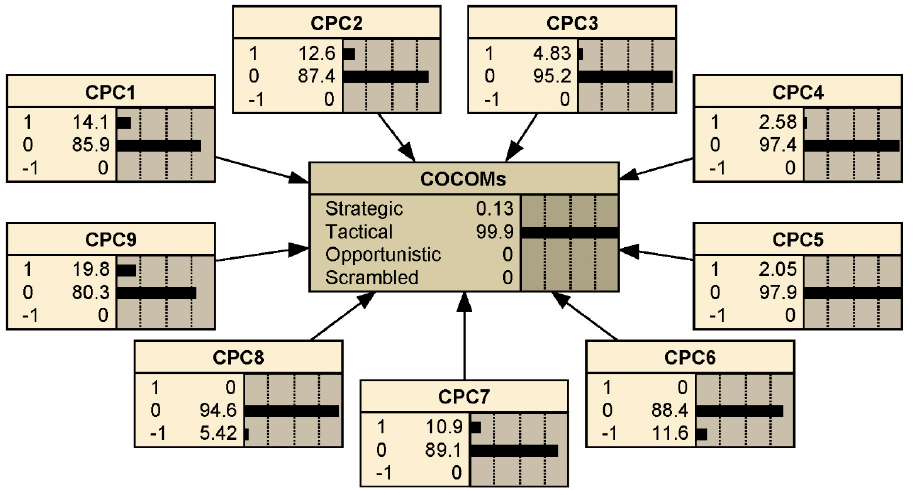
Figure 9. The probabilities of the COCOM node’s states.